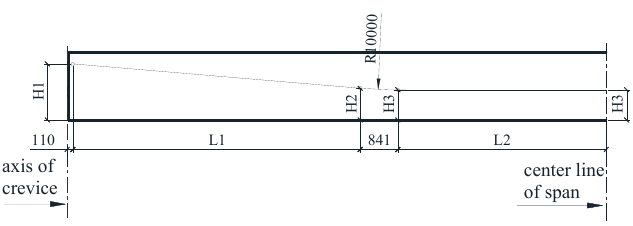
Figure 2. Details of reinforcement bars.